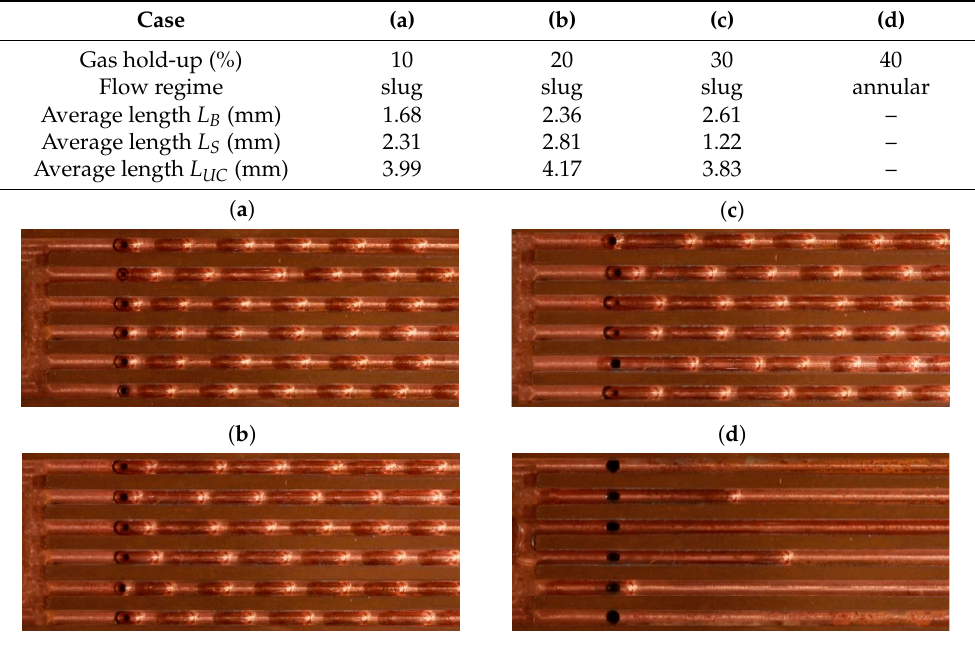
Figure 10. Dependence of the average Nusselt number on the gas hold-up at Re TP = 300. Bubbly, slug and annular flows (experimental data). Table 2. Visualization of two-phase flows at a gas content φ = 10–40%.